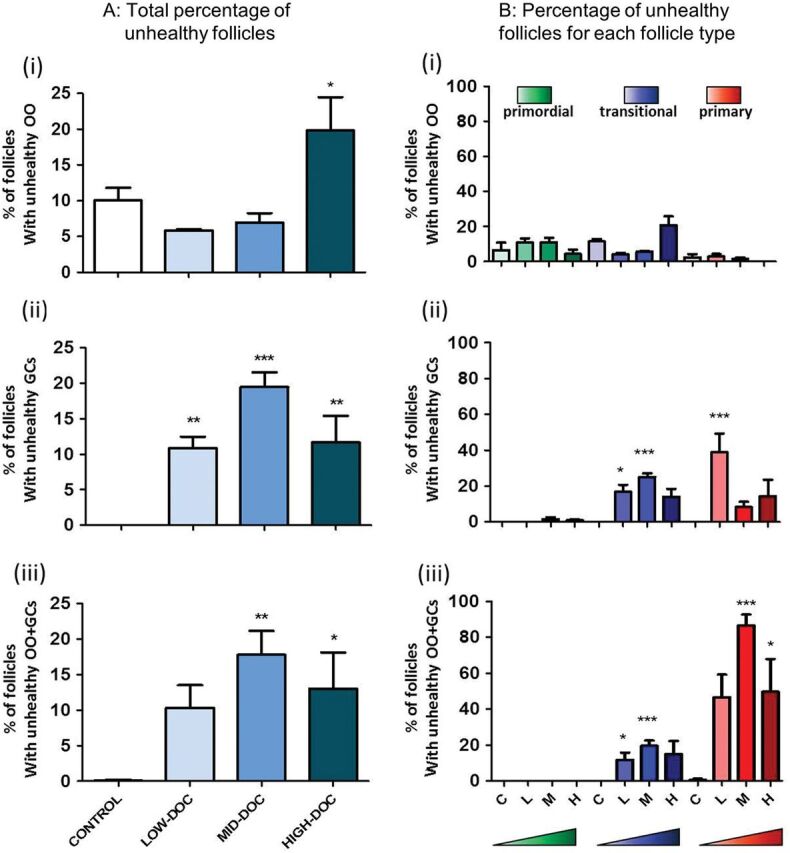
Docetaxel primarily damages GCs of growing follicles in mice. All unhealthy follicles were further classified as being unhealthy due to the presence of (i) unhealthy oocyte only; (ii) unhealthy GCs only; or (iii) both unhealthy oocyte and GCs (OO+GCs). (A) Total percentage of unhealthy follicles. An effect on health was seen in the follicles with unhealthy GCs only, where even LOW-DOC induced a significant increase: in contrast, only the HIGH-DOC treatment significantly increased the percentage of follicles with unhealthy oocytes. (B) Percentage of unhealthy follicles for each follicle type. Primordial follicles were unaffected by drug treatment, but growing transitional and primary follicles both exhibited poorer follicle health, with an increase in the percentage of follicles with unhealthy GCs only and in the OO+GC category, after exposure to DOC. CONTROL = C, LOW-DOC = L, MID-DOC = M, HIGH-DOC = H. Triangles and stronger colours indicate increasing DOC doses. Total of ovaries used in three independent experiments: CONTROL = 7, LOW-DOC = 7, MID-DOC = 8 and HIGH-DOC = 7. One-way ANOVA followed by Bonferroni post hoc tests were applied. Data are mean ± SEM. P < 0.05 (*), P < 0.01 (**), P < 0.001 (***) for DOC versus CONTROL.